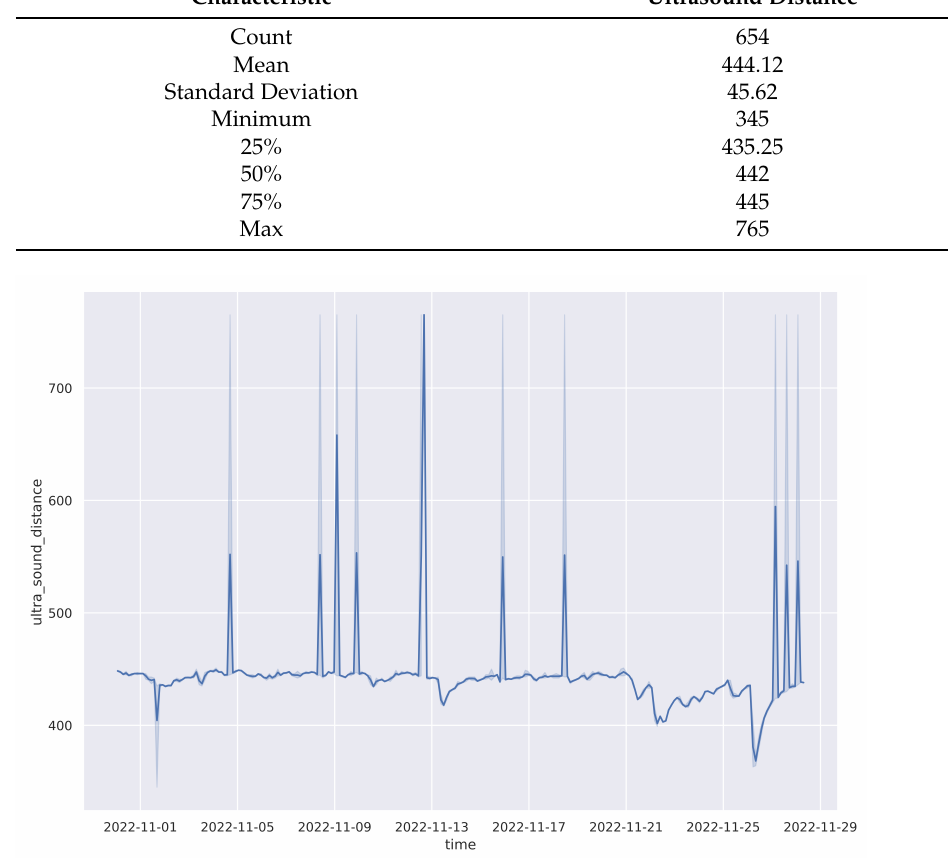
Figure 14. Ultrasound data plot for November 2022 at Kikuletwa